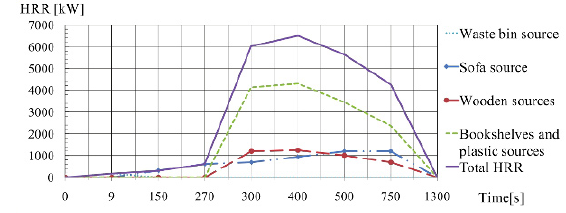
Figure 7. Fire sources fully prescribed HRR for CFD model.